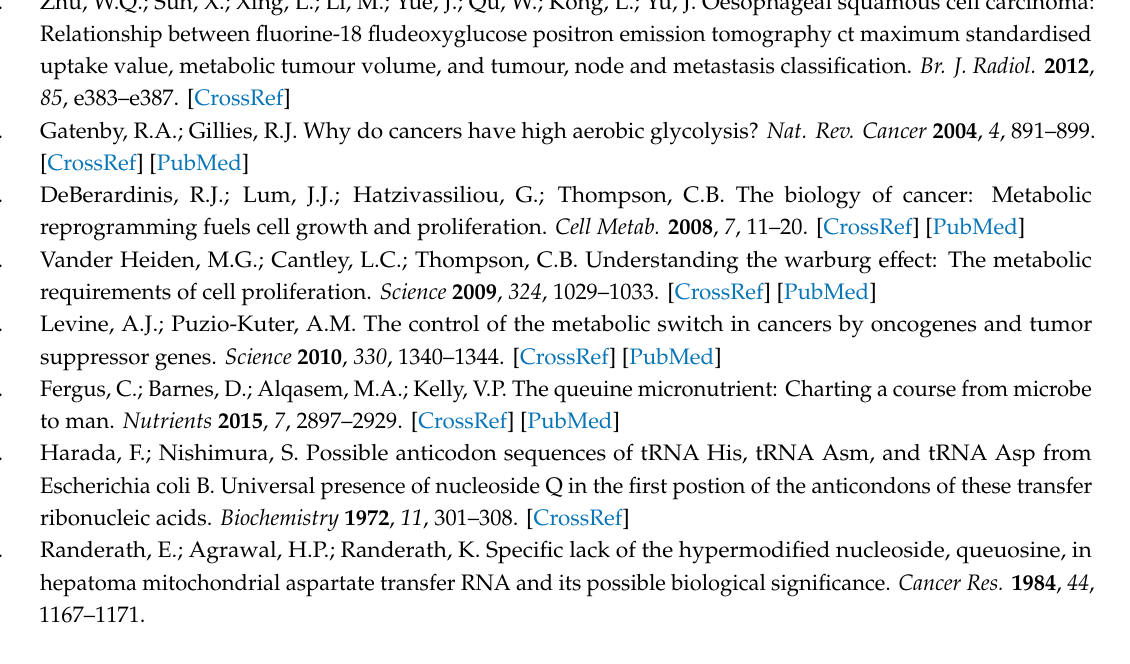
Figure S1: Queuine addition to serum-free medium results in full Q-modification of histidyl and asparaginyl tRNA in HeLa